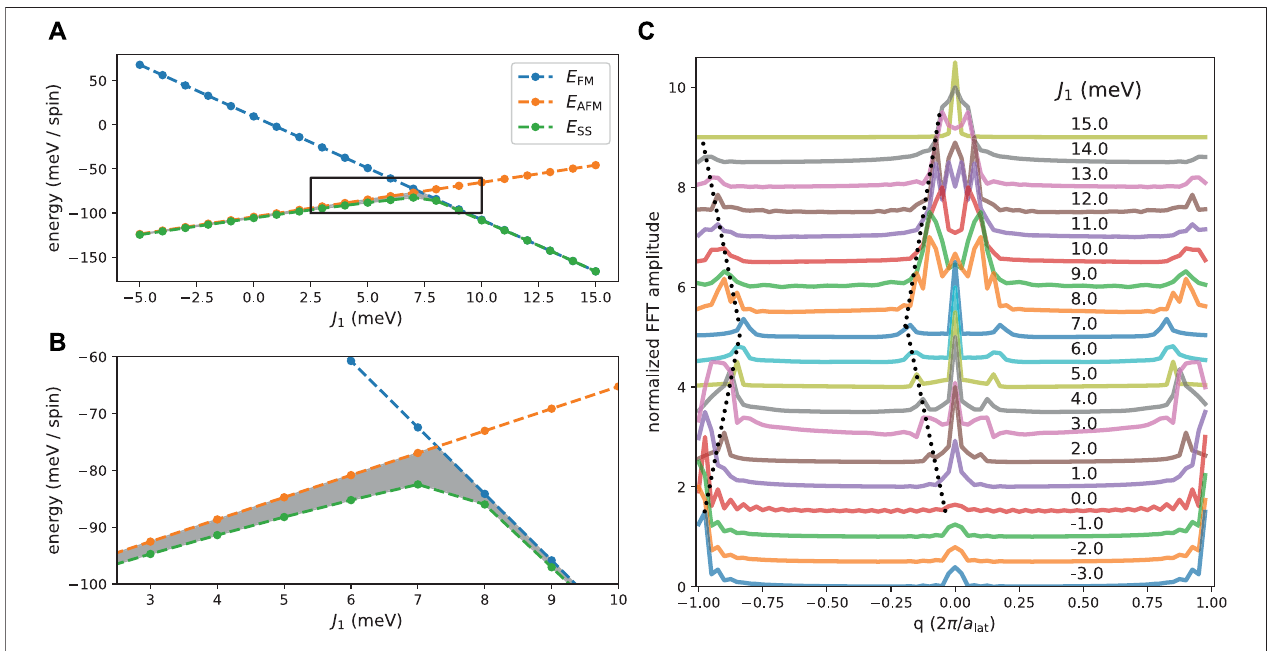
FIGURE 8 | (A) Spin-spiral (SS) energies as a function of the nearest neighbor interaction J 1 in comparison to ferromagnetic (FM) and antiferromagnetic (AFM) states.Exchangecouplingconstantsweretakenfromthe a lat (cid:1) 3 . 61 (cid:2) A calculationandthenearestneighborcouplings J 1 weremodi fi edintherangefrom − 5to15 meV. (B) Zoomintothetransitionregionmarkedbytheblackboxin (A) .ThegreyareahighlightstheenergygainintheSSstatecomparedtoFMorAFMstates. (C) Normalized Fourier transform of the z -component of the magnetization in the yz -plane. The spectra are shifted for clarity. Dashed lines indicate where E AFM − E SS < 2 meV and dotted lines are used for E FM − E SS < 2 meV. The solid and dashed grey lines are guides to the eye highlighting the change in the spin-spiral wavevector with J 1 .